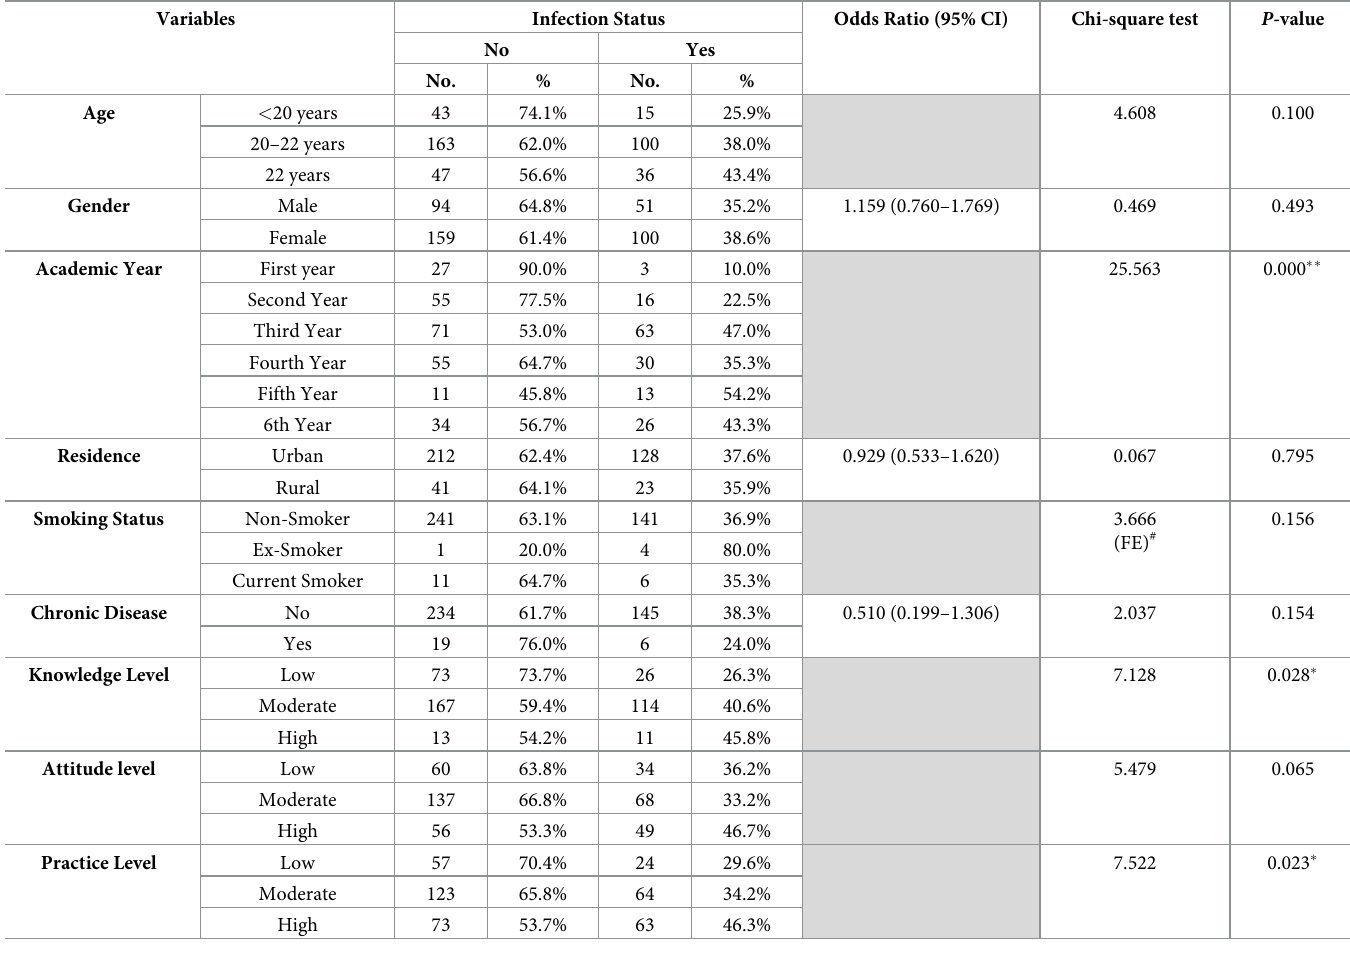
Table 2. Relationship of infection status of medical students with their characteristics and levels of knowledge, attitude, and practice.